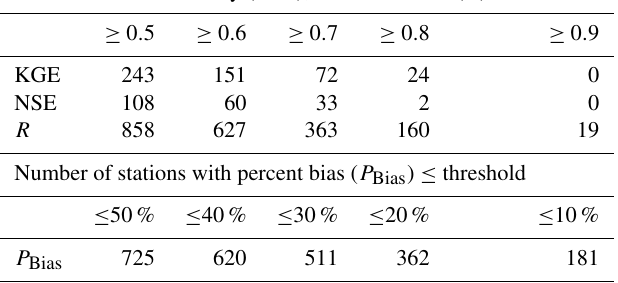
Table 6. Performance metrics based on 1366 GRDC